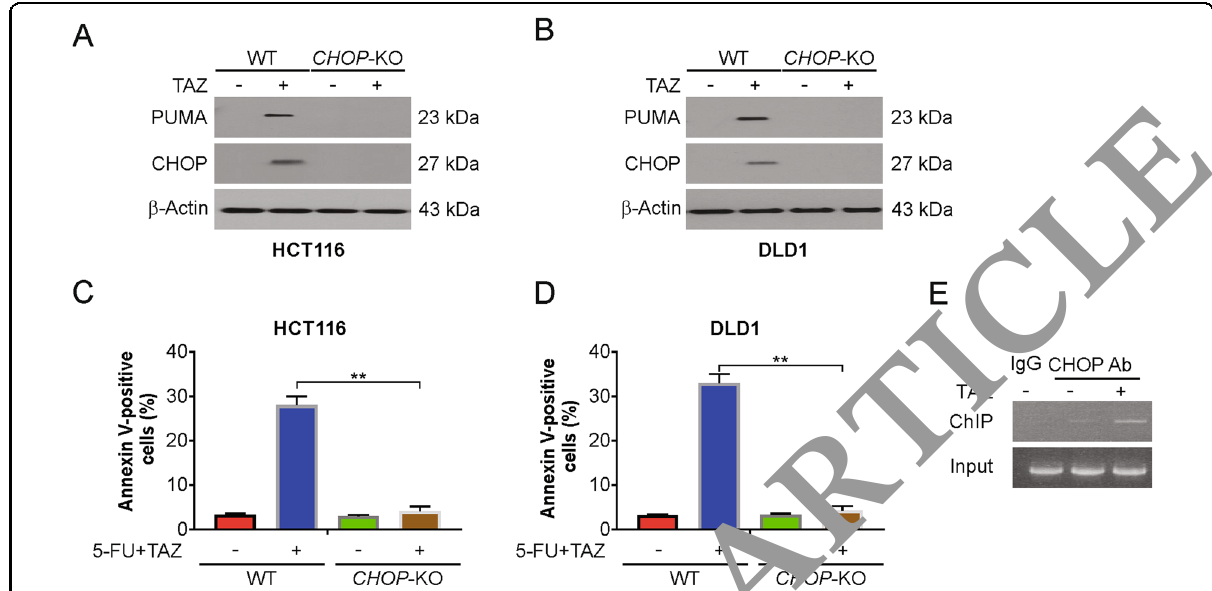
Fig. 5 CHOP mediated tazemetostat-induced PUMA upregulation. A WT and CHOP -KO HCT116 cells were treated with 0.5 μ M tazemetostat for 24 h. Indicated proteins were analyzed by western blotting. B WT and CHOP -KO DLD1 cells were treated with 0.5 μ M tazemetostat for 24 h. Indicated proteins were analyzed by western blotting. C WT and CHOP -KO HCT116 cells were treated with the combination of 2.5 μ g/mL 5-FU and 0.5 μ M tazemetostat for 24 h. Apoptosis was analyzed by fl ow cytometry. D WT and CHOP -KO DLD1 cells were treated with the combination of 2.5 μ g/mL 5-FU and 0.5 μ M tazemetostat for 24 h. Apoptosis was analyzed by fl ow cytometry. E Chromatin immunoprecipitation (ChIP) was performed